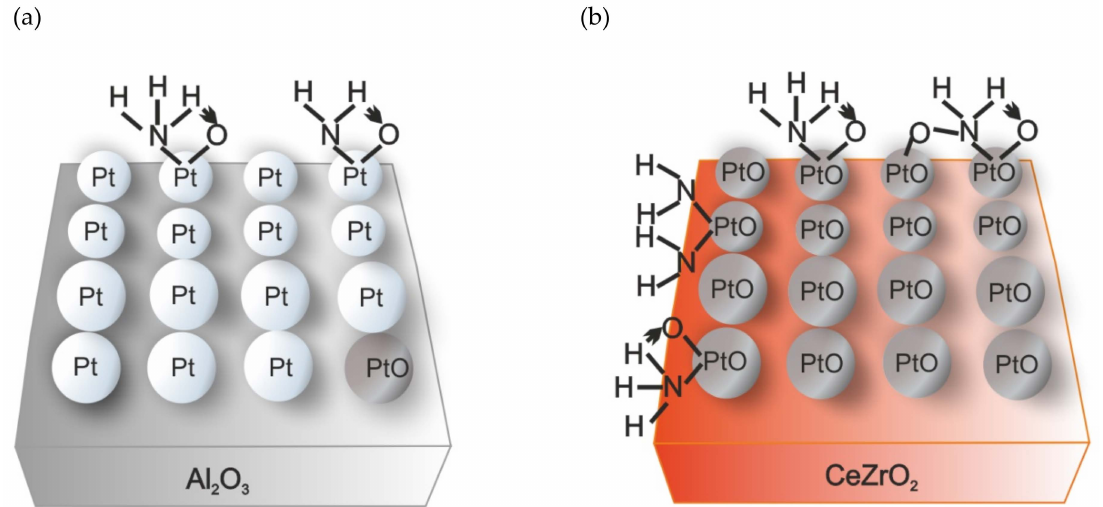
Figure 2. ( a ) Reaction mechanisms and Pt states over Pt/Al 2 O 3 and ( b ) Pt/CeZrO 2 . Reprinted from [42] with permission from ACS